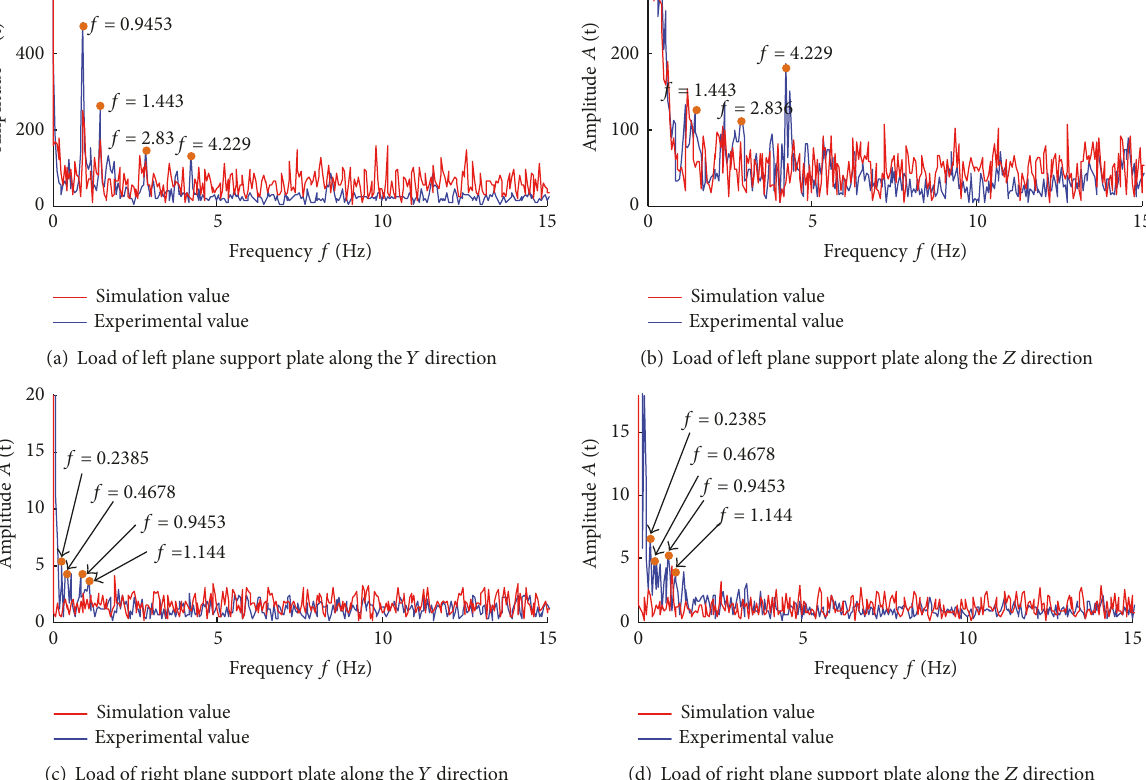
(d) Load of right plane support plate along the 𝑍 direction Figure 9: Amplitude-frequency response curves for the plane support